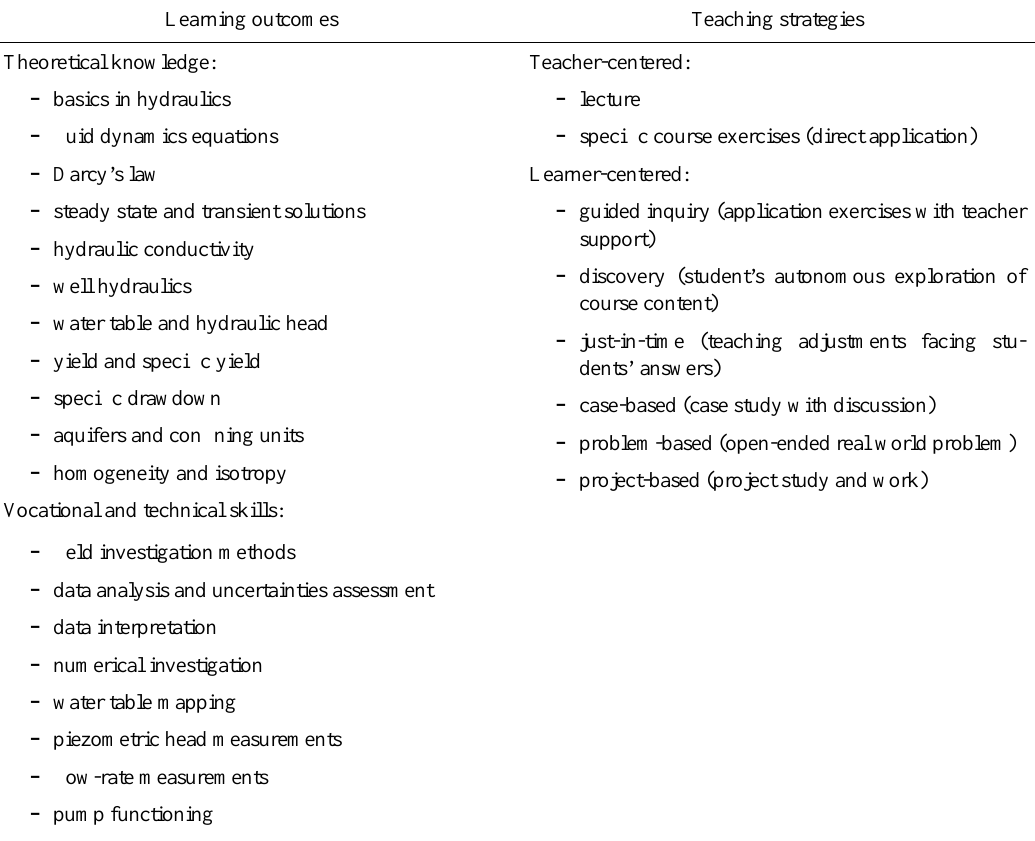
Table 1. Summary table of groundwater flow processes topics associated to teaching